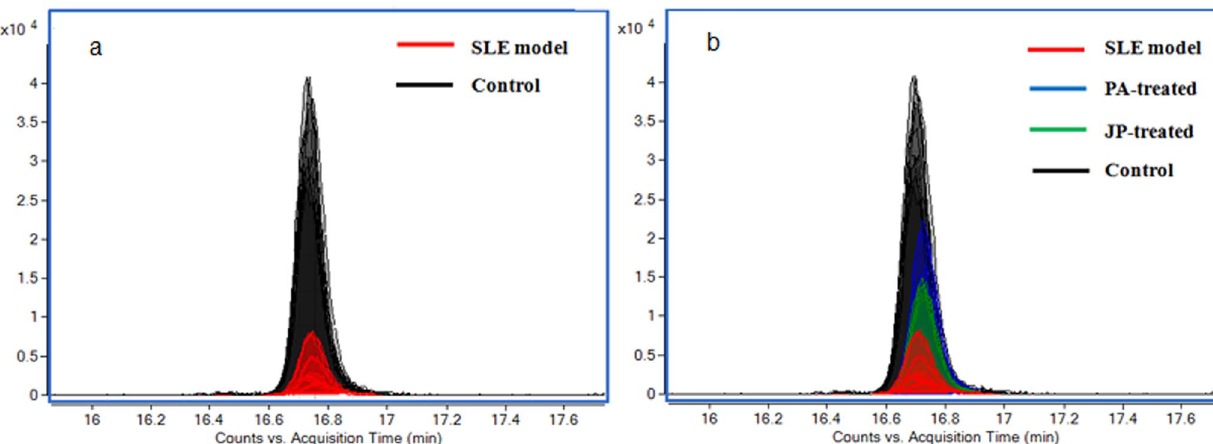
Figure 4. (a) Merged EIC of 14-HDOHE based on the SLE model group and control group. The relative content of 14-HDOHE significantly increased in SLE model mice. (b) Merged EIC of 14-HDOHE based on SLE model group, control group, JP-treated group, and PA-treated group.